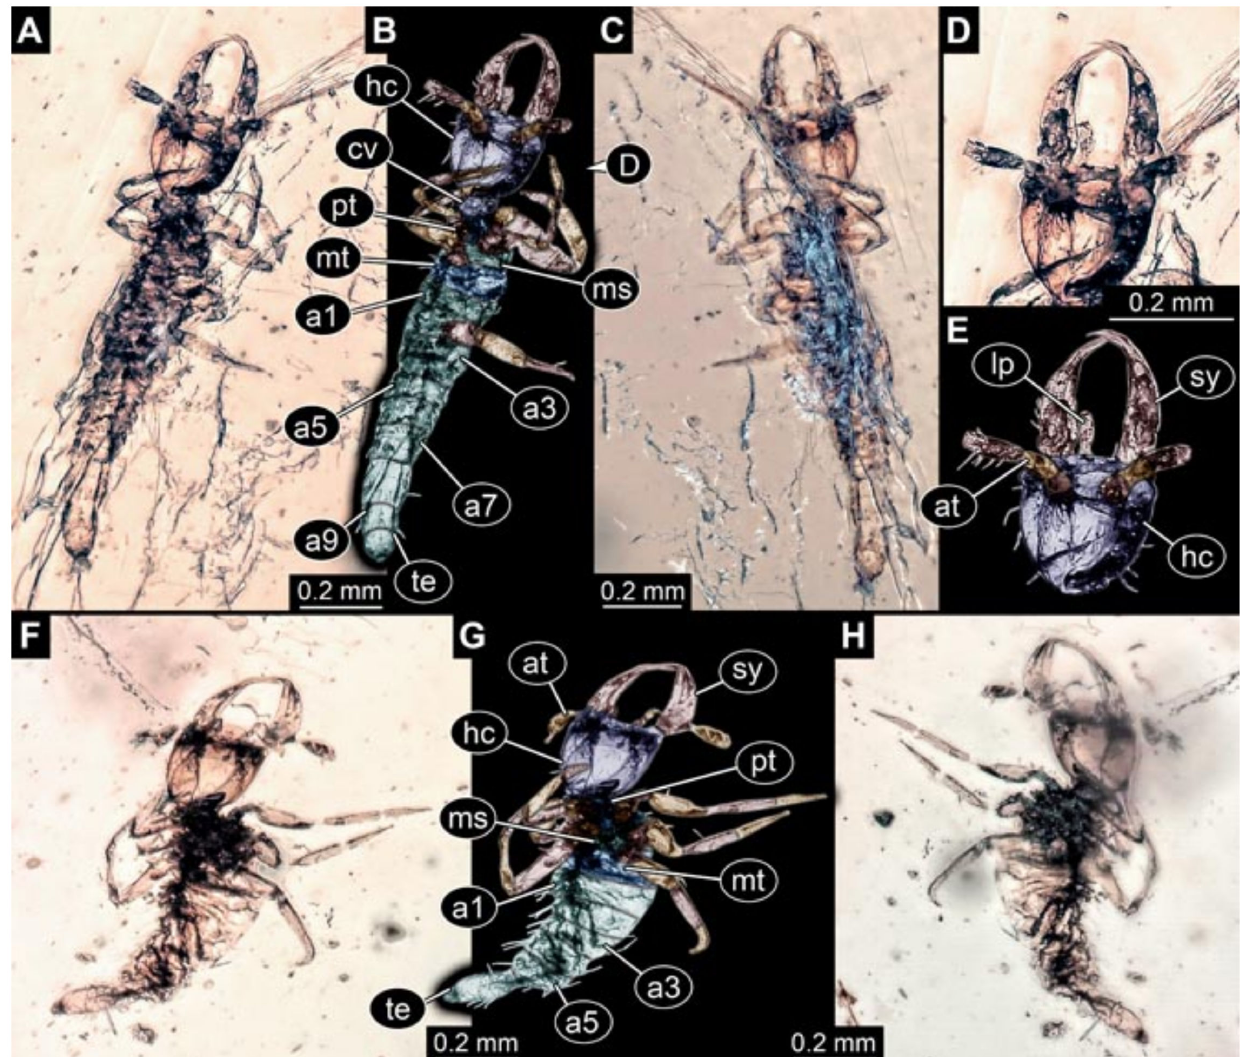
Figure 21. Specimens in Myanmar amber. ( A – E ) Specimen 5850 (PED 0791-1). ( A ) Ventral view. ( B ) Ventral view, colour-marked. ( C ) Dorsal view. ( D ) Close-up of head in ventral view. ( E ) Close-up of head in ventral view, colour- marked. ( F – H ) Specimen 5851 (PED 0791-2). ( F ) Ventral view. ( G ) Ventral view, colour-marked. ( H ) Dorsal view. Abbreviations: a1–a9 = abdomen segment 1–9; at = antenna; cv = cervix; hc = head capsule; lp = labial palp; ms = mesothorax; mt = metathorax; pt = prothorax; sy = stylet; te = trunk